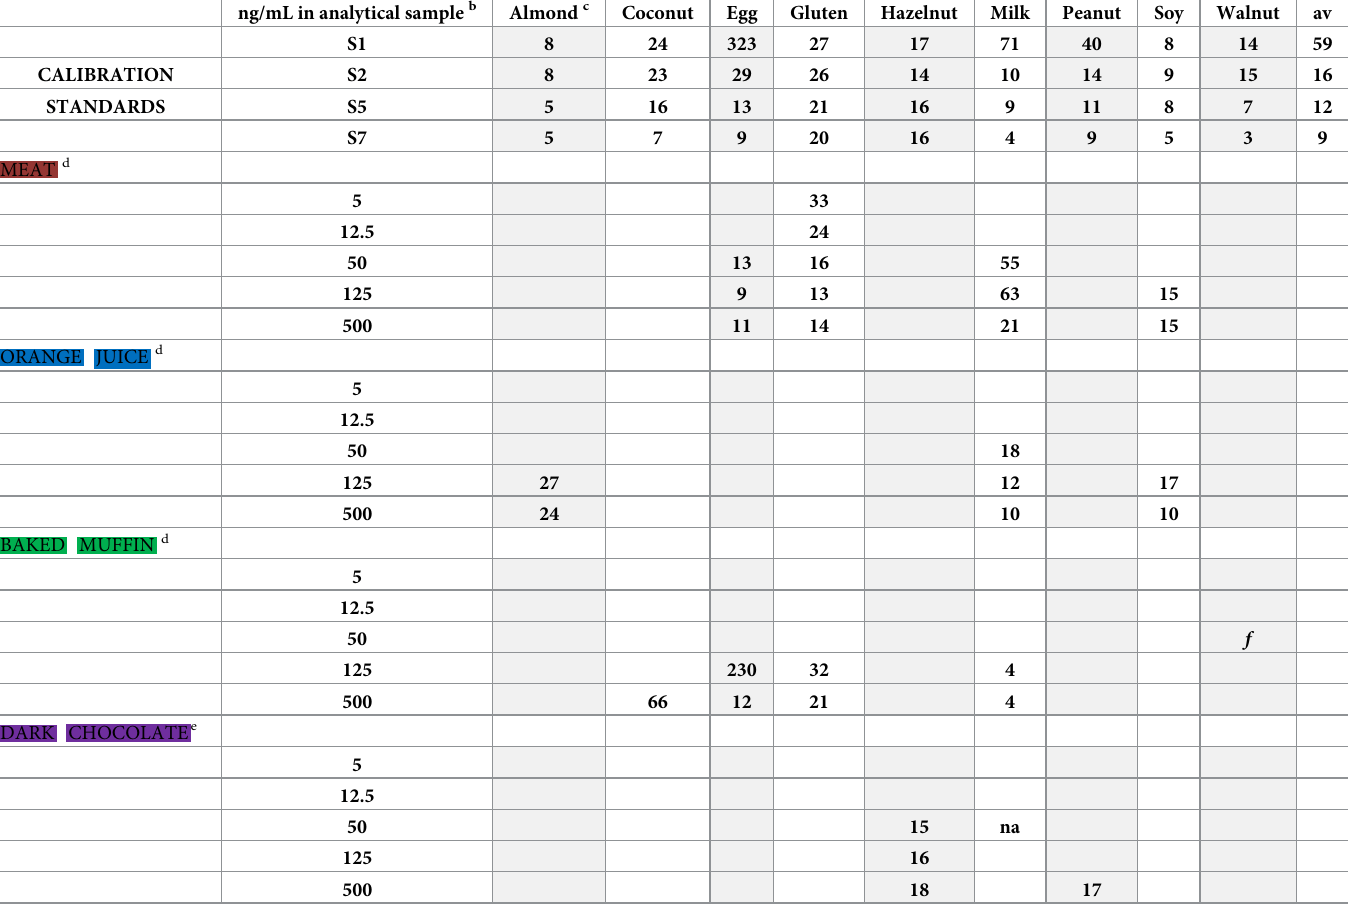
Table 11. Percent coefficient of variation (%CV) of complementary antibody ratios a . ng/mL in analytical sample